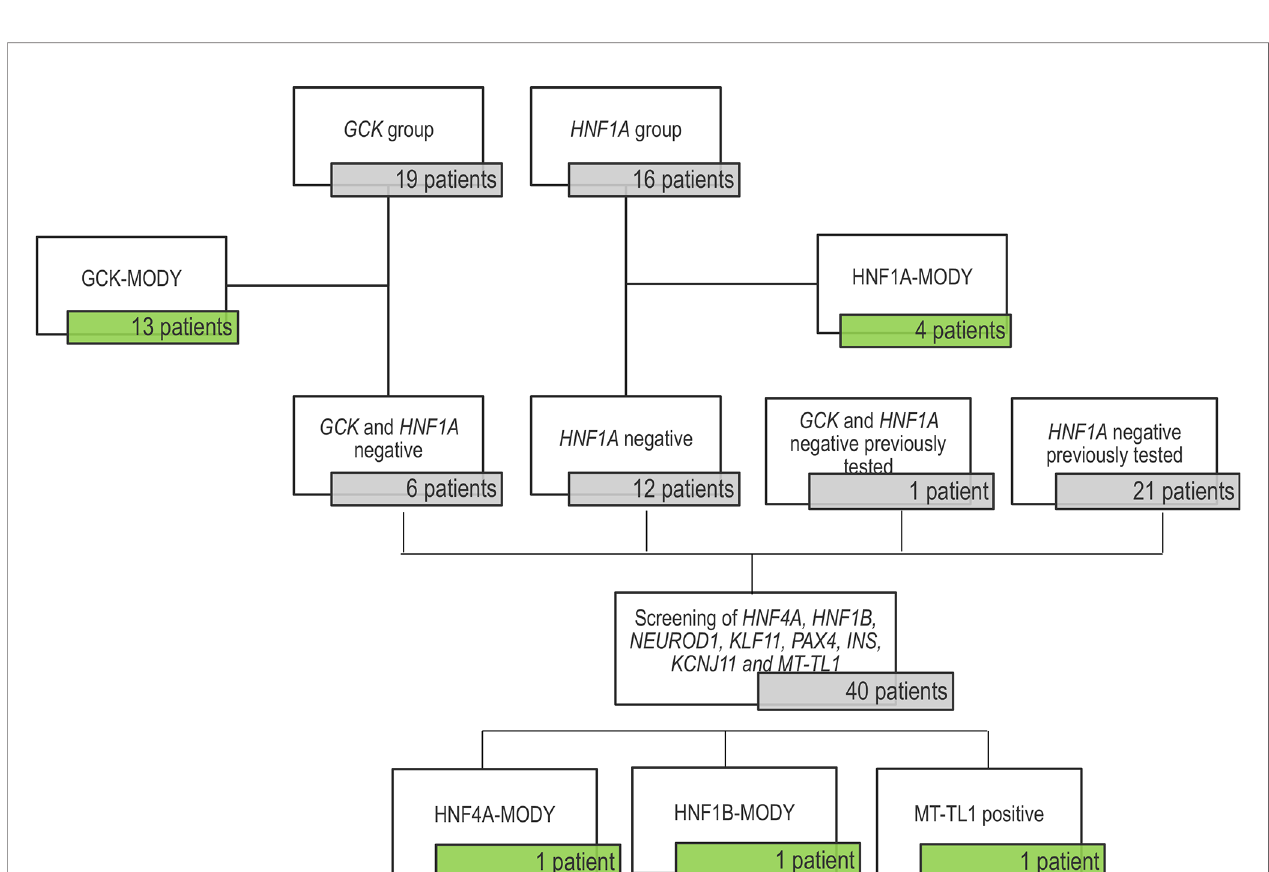
FIGURE 1 | Flow diagram of the sample tested in this study. The untested patients included 19 patients in the GCK-MODY group and 16 patients for being tested for HNF1A variants. We found 13 GCK carriers and 4 patients with HNF1A-MODY. The 6 GCK negatives probands were screened for HNF1A variants and they were all negatives. This study also included a cohort previously search for variants in in the HNF1A gene (21 patients) with negative results; and one patient negative for both genes. Forty patients presented no variant in the two major genes (GCK and HNF1A) and were tested for HNF4A , HNF1B , NEUROD1 , KLF11 , PAX4 , INS , KCNJ11 and MT-TL1 , resulting in the identi fi cation of three patients with variants.